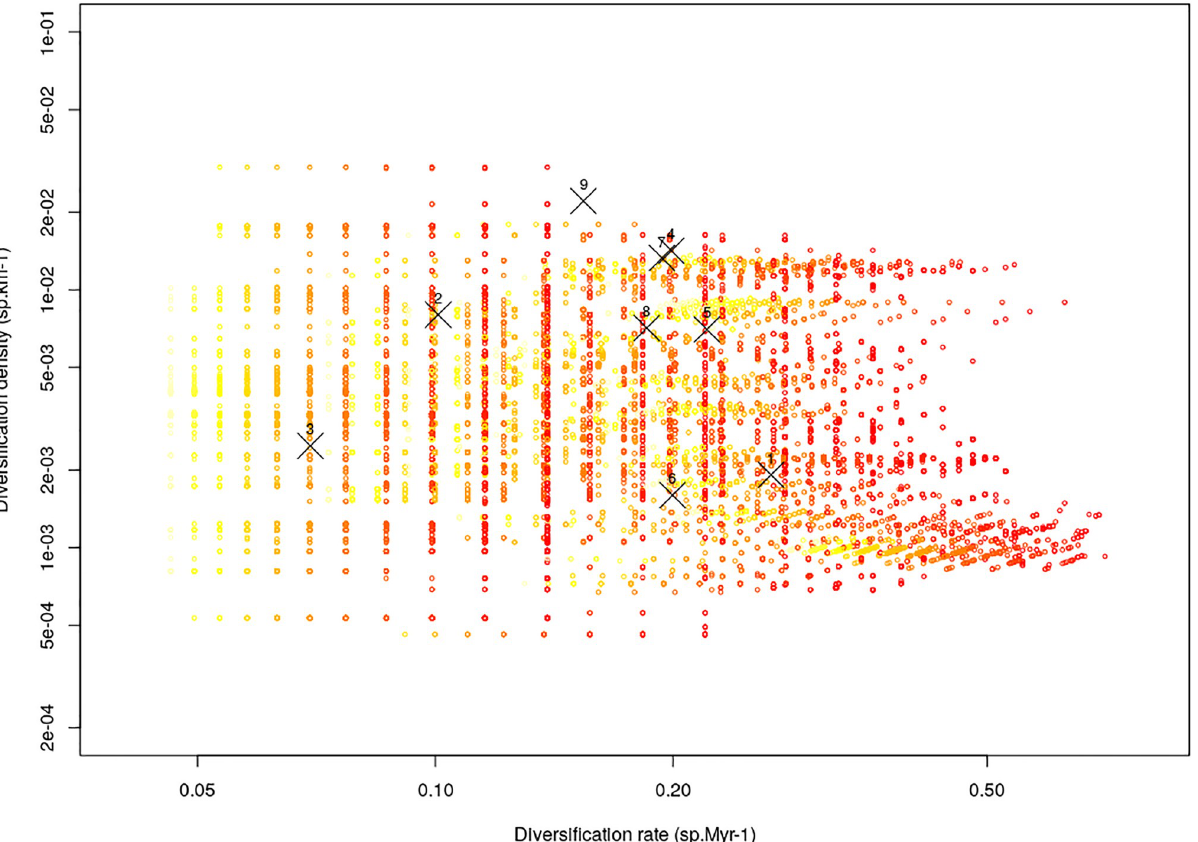
Fig 3. Decoupling of two aspects of diversification. The graph shows the relationship between the average diversification rate, log(richness)/age , and the average diversification density, log(richness)/sqrt(area) within clades. Black crosses show data for the nine genera of Alooideae for which this metric could be calculated, with numbers depicting each genus. 1: Aloe , 2: Aloiampelos , 3: Aloidendron , 4: Astroloba , 5: Gasteria , 6: Gonialoe , 7: Haworthia , 8: Haworthiopsis , 9: Tulista . Open circles present data for the 100 posterior trees and for all 11 time cut-offs, with the color scale ranging from 15 Myr old clades in yellow to 5 Myr old clades in red. In 98.7% of all comparisons, diversification rate and density were not significantly correlated.